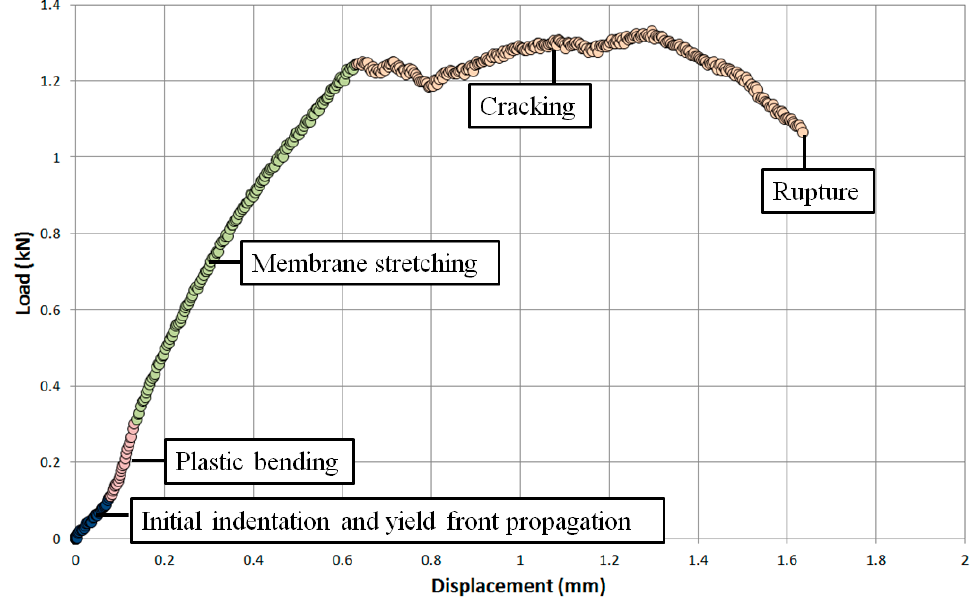
Figure 9. Load-displacement relationship of a SP tensile test on a cast and HIP Ti-6Al-4V specimen.